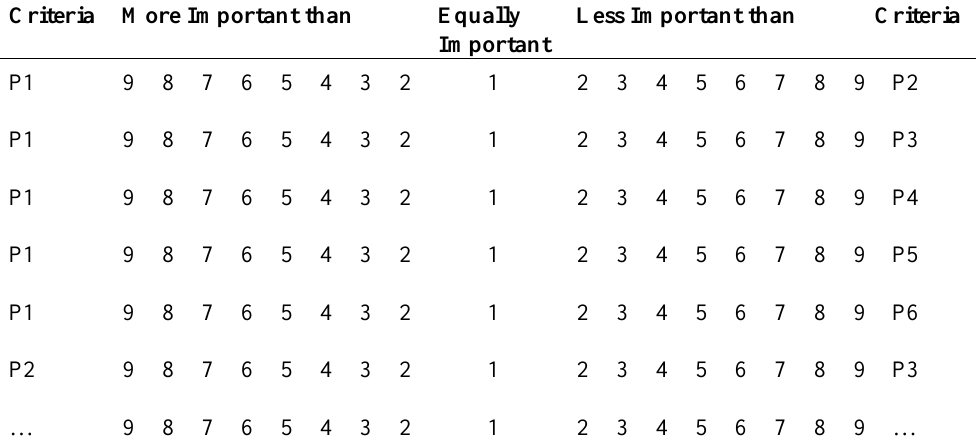
Table 2: AHP Pairwise Comparison of Measurement Scale Criteria More Important